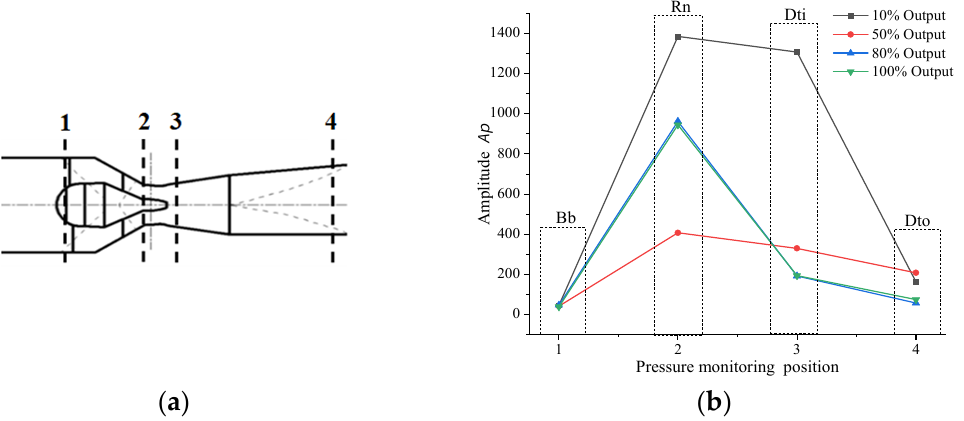
Figure 13. Pressure pulsation of tubular turbine prototype. ( a ) Arrangement of measuring points for real machine pressure pulsation; ( b ) test pressure fluctuation amplitude curves at different monitoring points under different outputs.